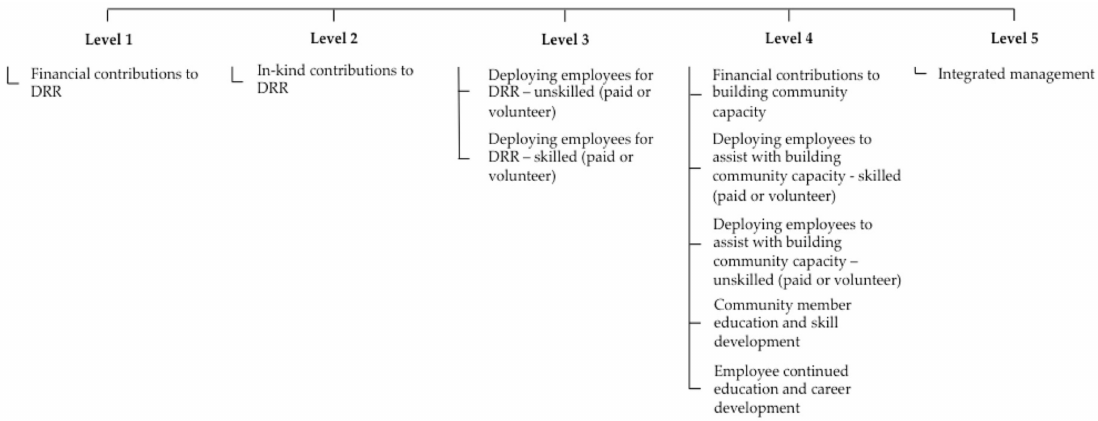
Figure 3. Tiered indicator framework to evaluate the disaster relief and resilience dimension of CSR vision/policy statements and goals.